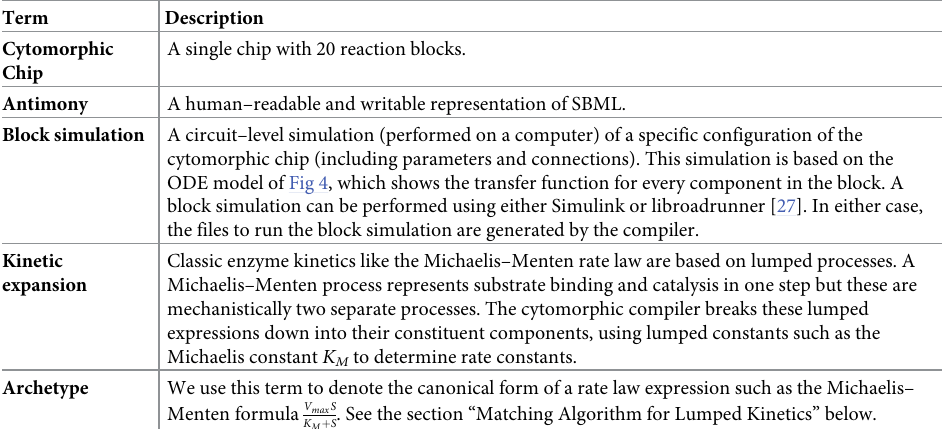
Table 1 lists definitions for terminology used in this article.